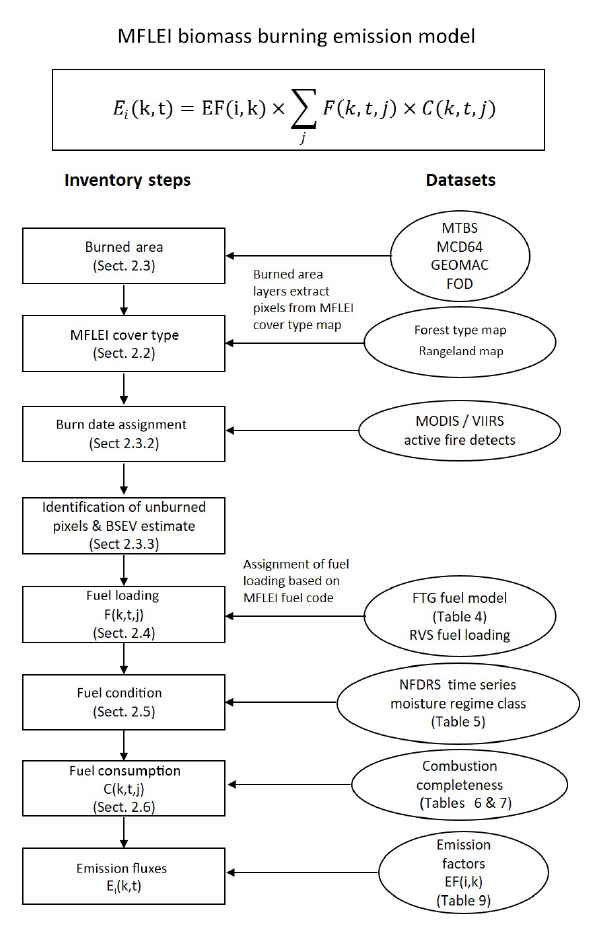
Figure 1. Diagram of MFLEI biomass burning emission model methodology and